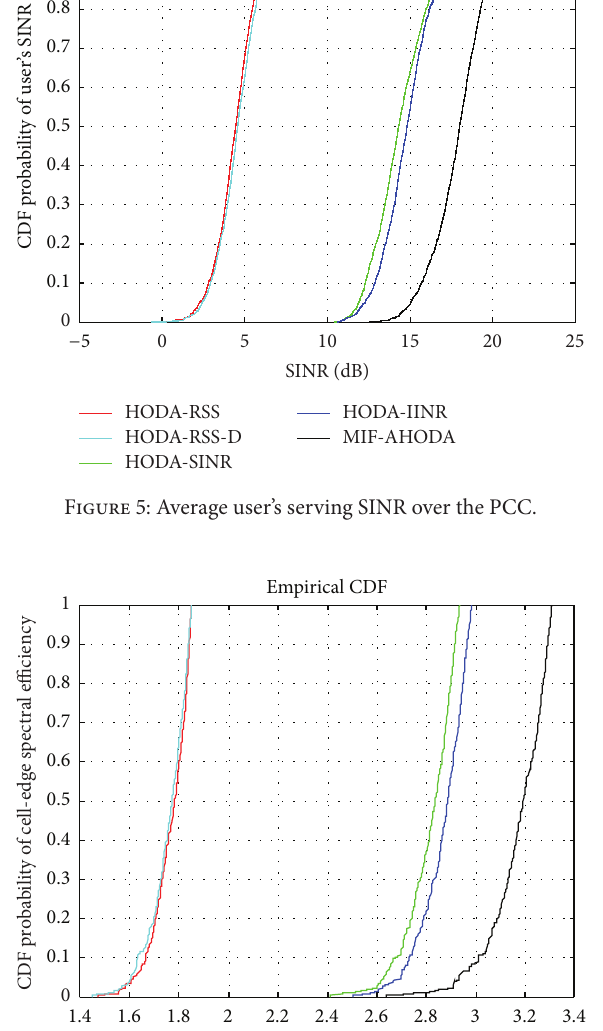
with hysteresis and threshold levels (SINR 𝑆 > 𝑀 + 𝛾 ).